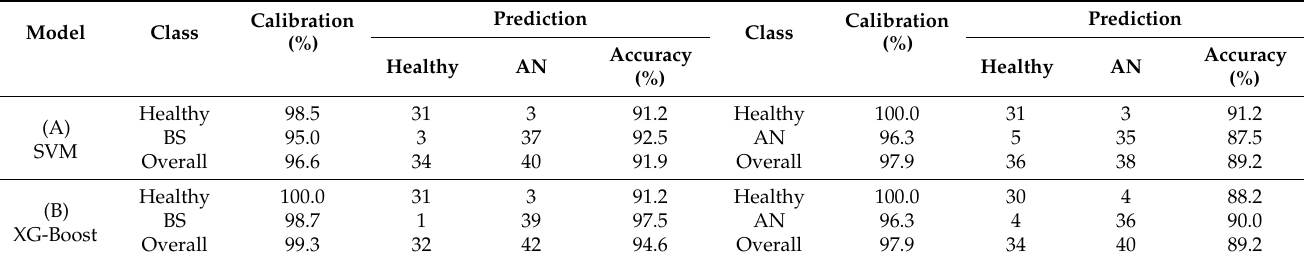
Table 3. Classification results of healthy and brown spot cucumber, healthy and anthracnose cucum- ber based on SVM and XGBoost algorithms